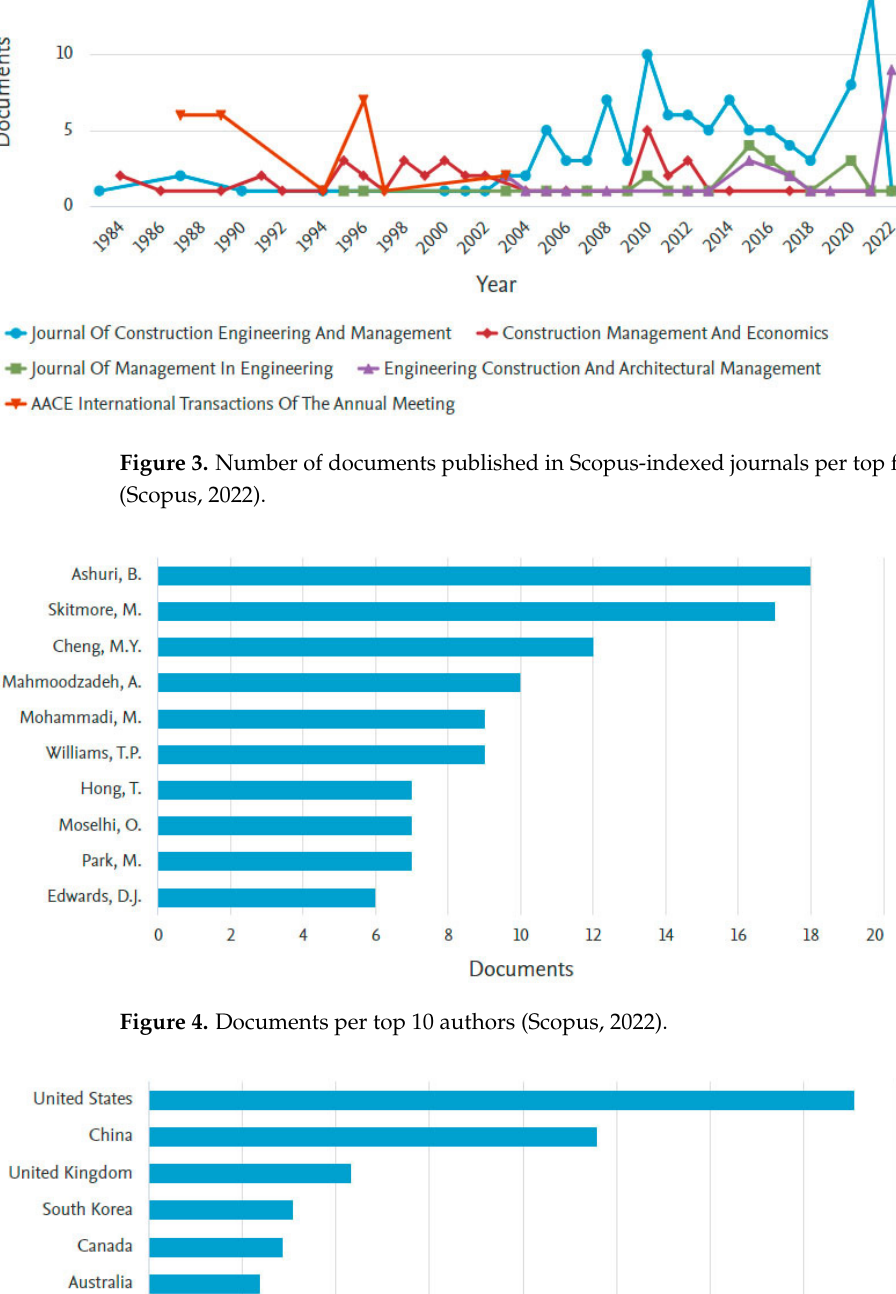
Figure 2. Number of documents published in Scopus-indexed journals per year (Scopus, 2022).